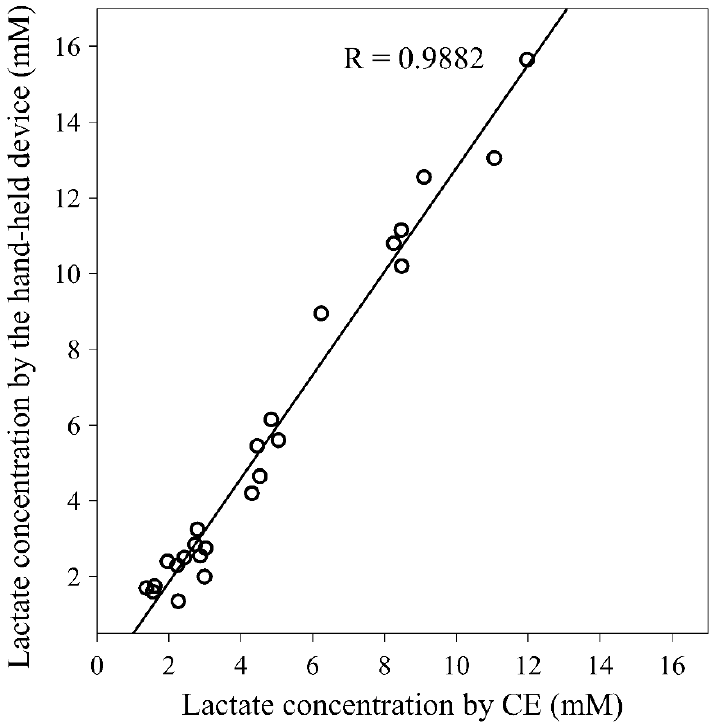
Figure 2. Correlation of the CE method with the hand-held lactate analyzer.